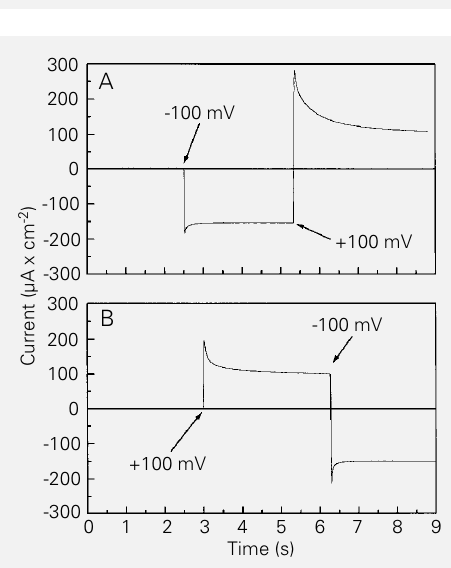
Figure 4 - Voltage pulse combi- nations. Solutions are symmetri- cal KCl Ringer with [Cl - ] = 23.4 mM. In A the voltage sequence is 0 fi